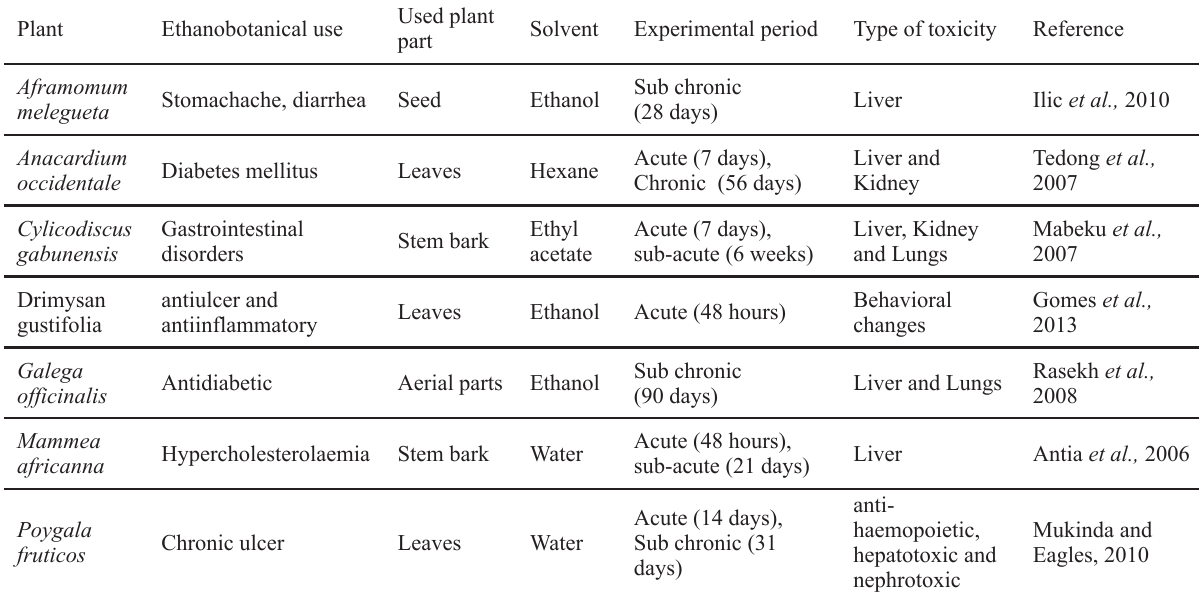
Table 4: Reported toxic effect of plants which are used in traditional medicine.